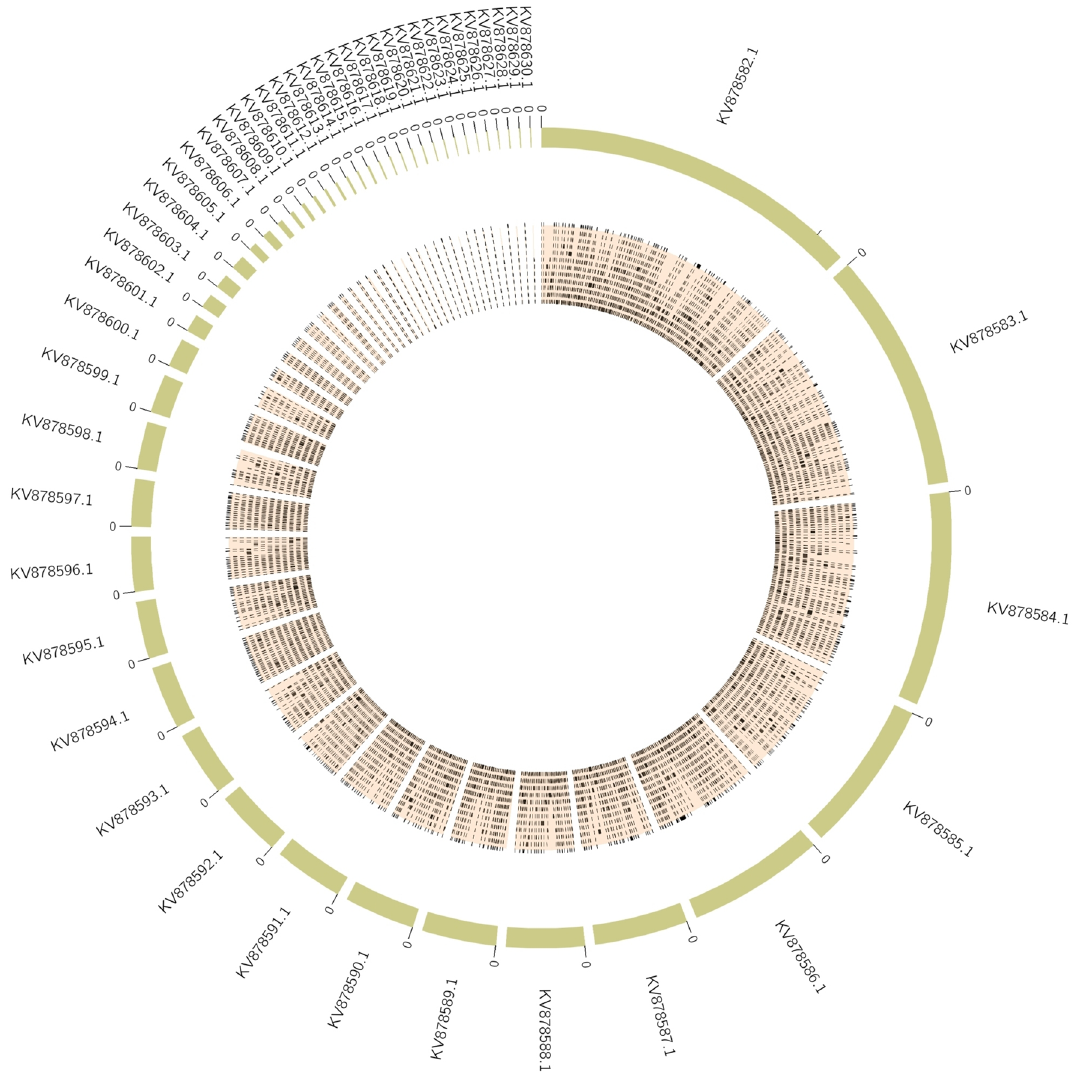
Figure 7. Circos plot of A. sydowii BOBA1 using ClicO (http:// 103. 47. 253. 210: 3000/ home). The yellow green tiles represents the A . sydowii CBS 593.65 and the orange black bar shows the similarity of assembled genome contigs with the reference